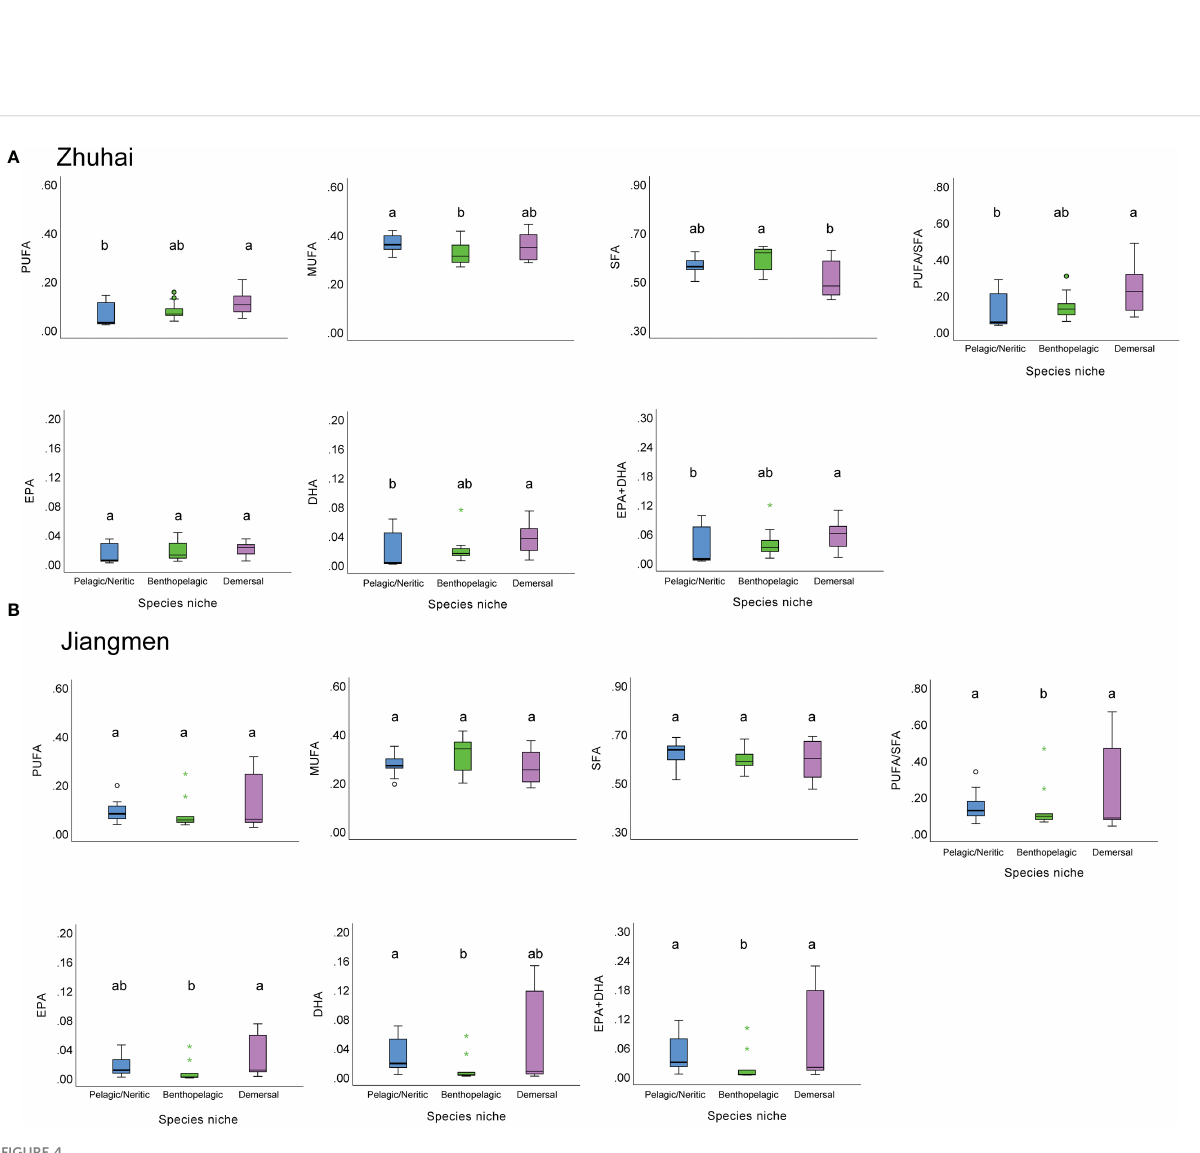
FIGURE 4 The box plots of fatty acids composition of fi shes in different species niches from Zhuhai (A) and Jiangmen (B) . Different lower-case letters indicate a signi fi cant difference among